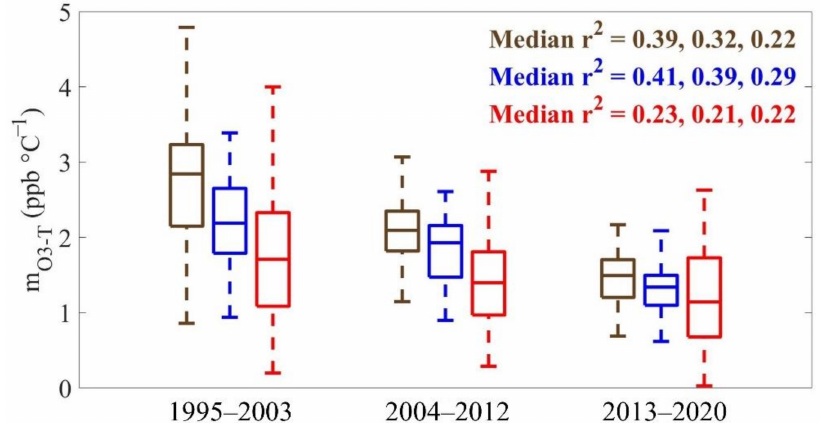
Figure 4. The slope of the maximum daily 8-h average O 3 versus the daily maximum temperature (m O3-T ; ppb ◦ C − 1 ) for the urban nonattainment areas (NAAs) in the eastern U.S. (brown), midwestern U.S. (blue), and western U.S. (red) from 1995–2003, 2004–2012, and 2013–2020. All slopes were found using coincident MDA8 O 3 and TMAX data collected from May to September. The components of each boxplot have the same meanings as in Figure 3. Median r 2 values of the O 3 versus temperature relationship for each region are listed for the 1995–2003 (first values), 2004–2012 (second values), and 2013–2020 (third values) time